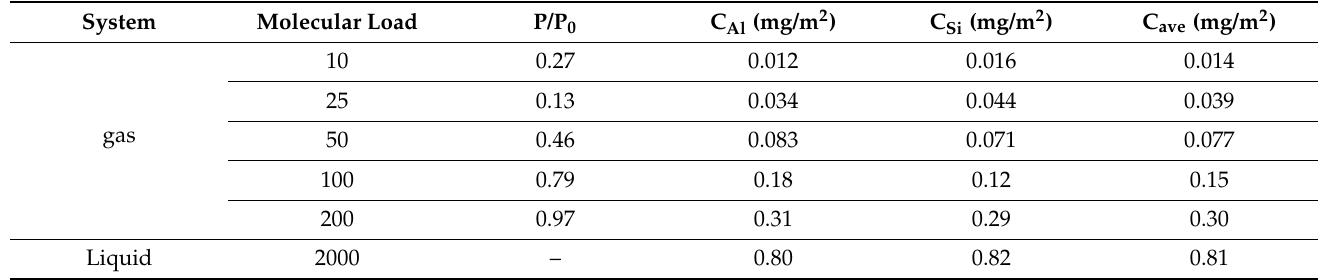
Table 3. Adsorption capacity per layer calculated directly from the simulation and predicted for given relative gas pressures on